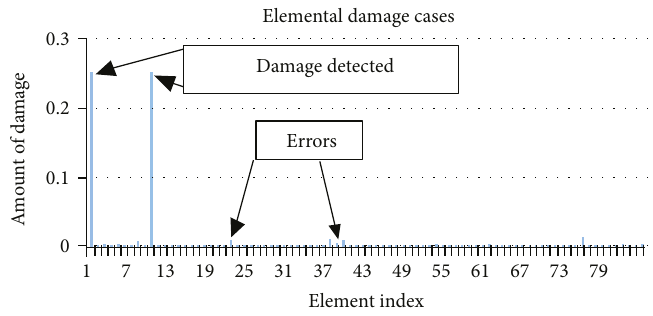
Figure 7: Damage locations in damage scenario 2.